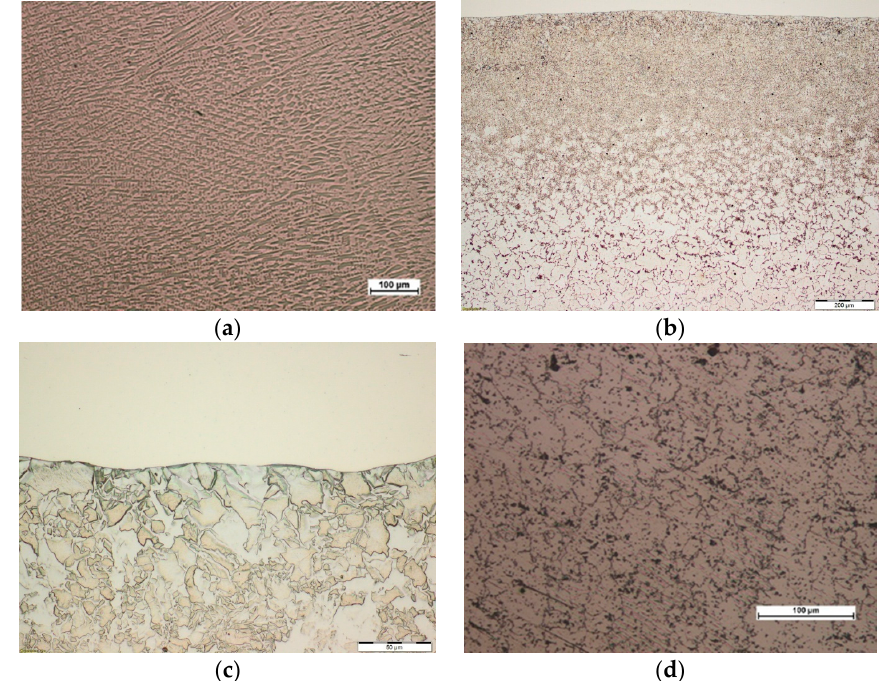
Figure 6. View of the microstructure of Inconel 625 superalloy coating layer obtained in the process of powder laser surfacing on the outer surface of 16Mo3 steel pipe (sample L4): ( a ) coating layer area, mag. 100×, ( b ) general view HAZ area, mag. 100×, ( c ) HAZ area at the fusion line, mag. 500×, ( d ) base material, mag. 200×.